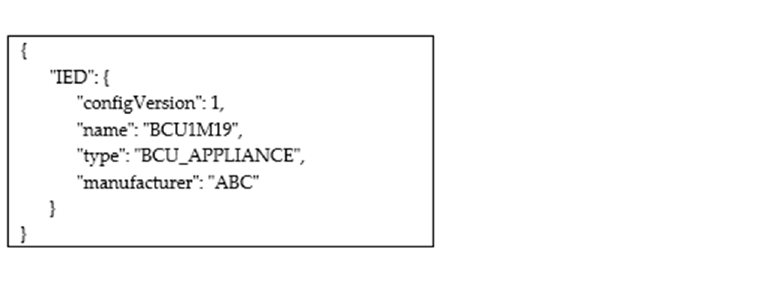
Figure 6. Example of a JSON frame containing the data type description of the IED maintained by the IEC 61850 Server.